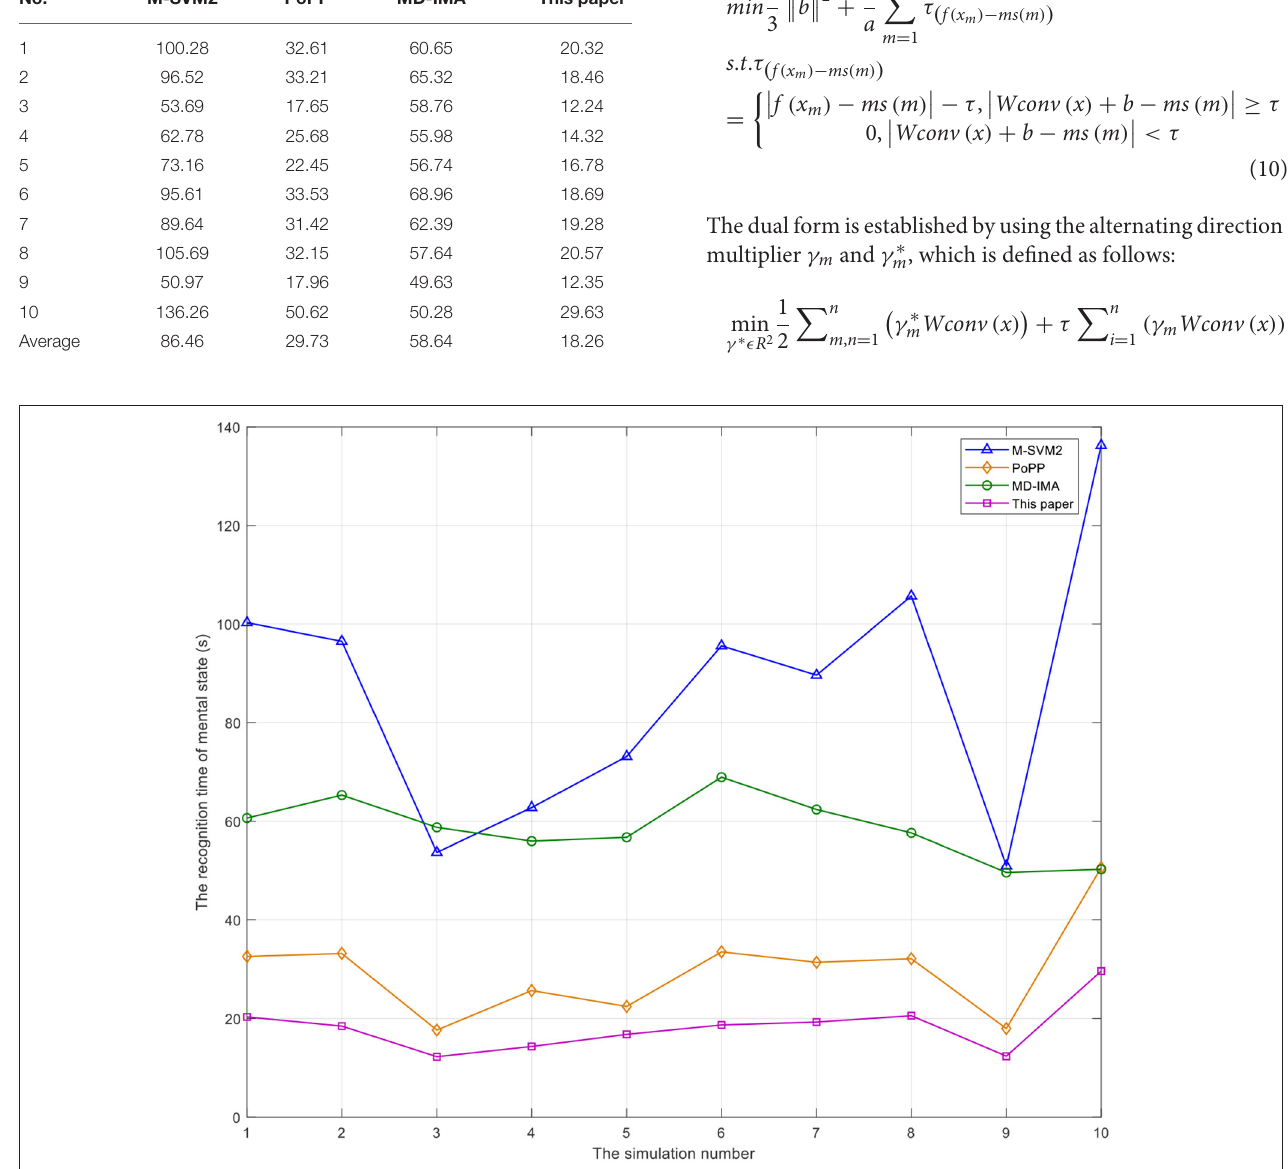
FIGURE 5 | The comparison of recognition time of mental state recognition of undergraduates in medical college by different methods.